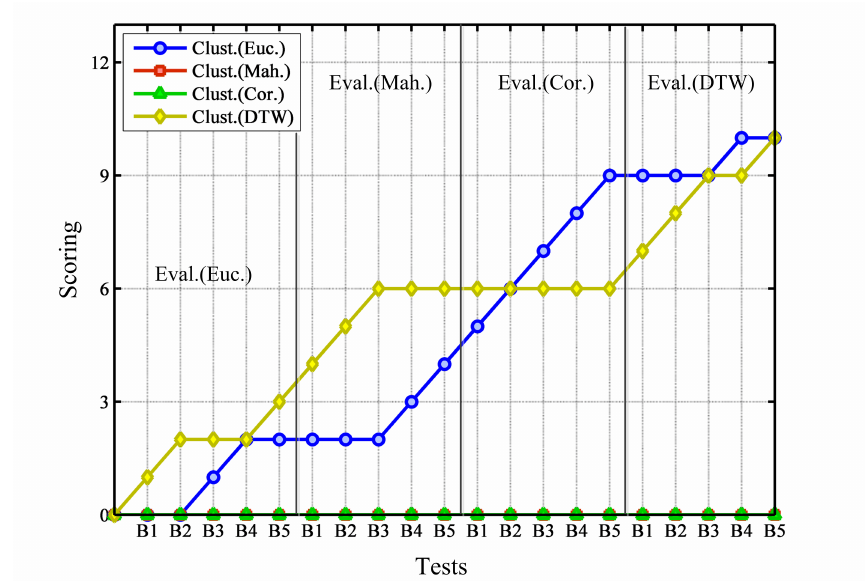
Figure 5. Assessment carried out using data saved for